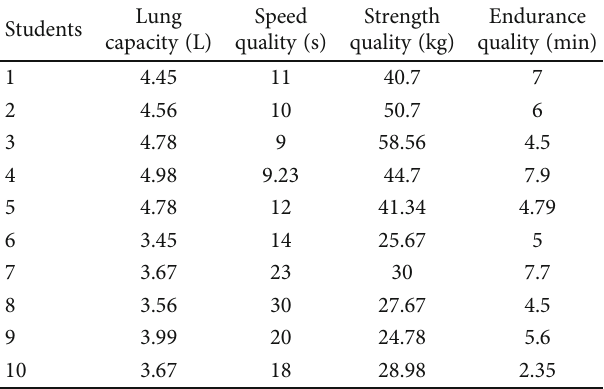
Table 3: Indicators of the body.